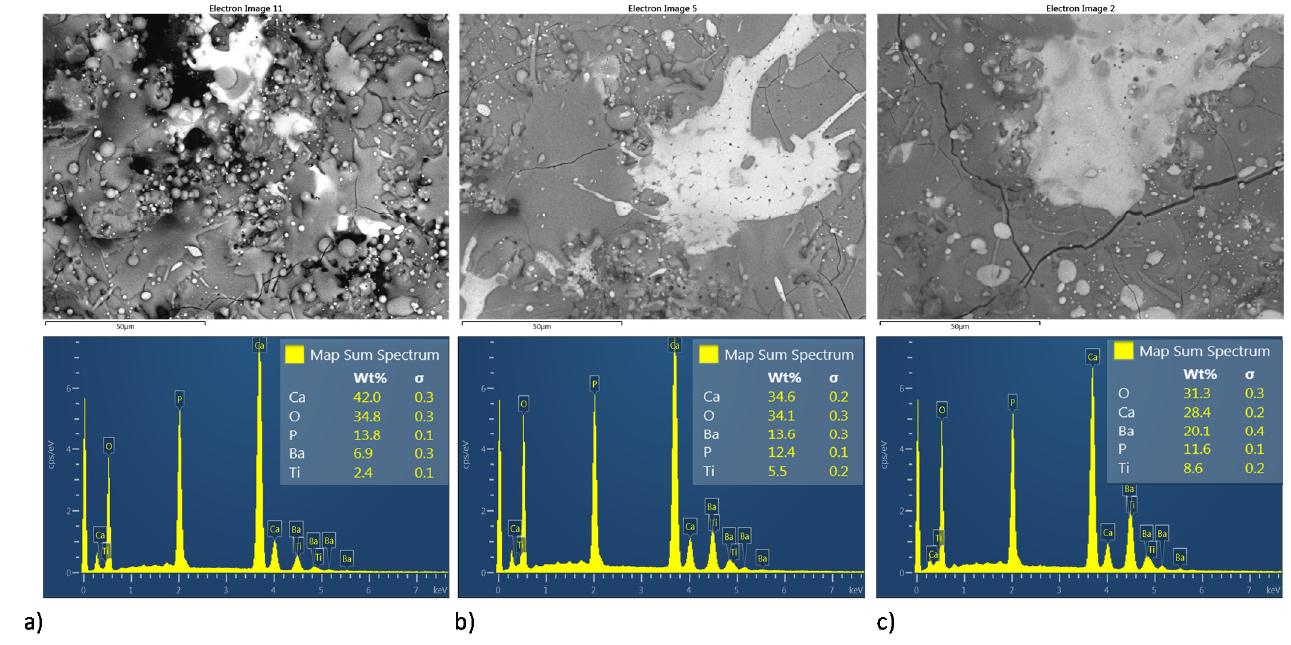
Figure 11. Superficial BSE micrographs and EDS spectrum of coatings development by MSH; (( a – c ) HA10BT S, HA30BT S, and HA50BT S respectively).